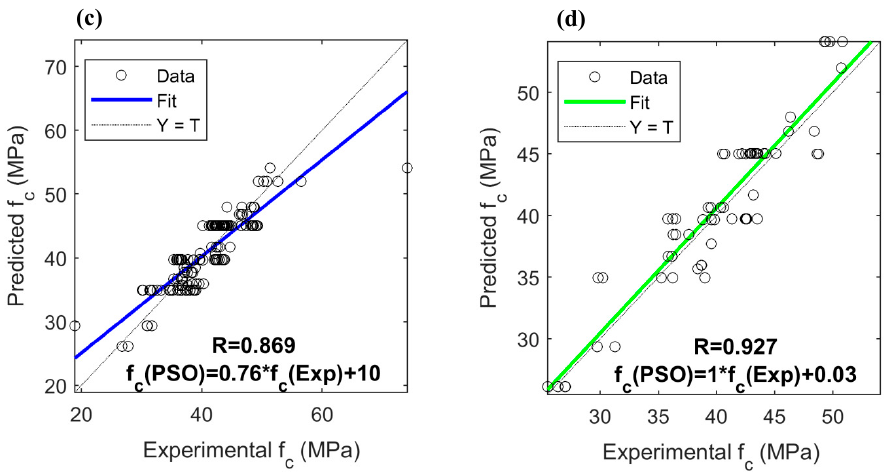
Figure 7. Correlation coefficients of different models: ( a ) training PSOANFIS, ( b ) testing PSOANFIS, ( c ) training GAANFIS, and ( d ) testing GAANFIS. Appl. Sci. 2019 , 9 , x